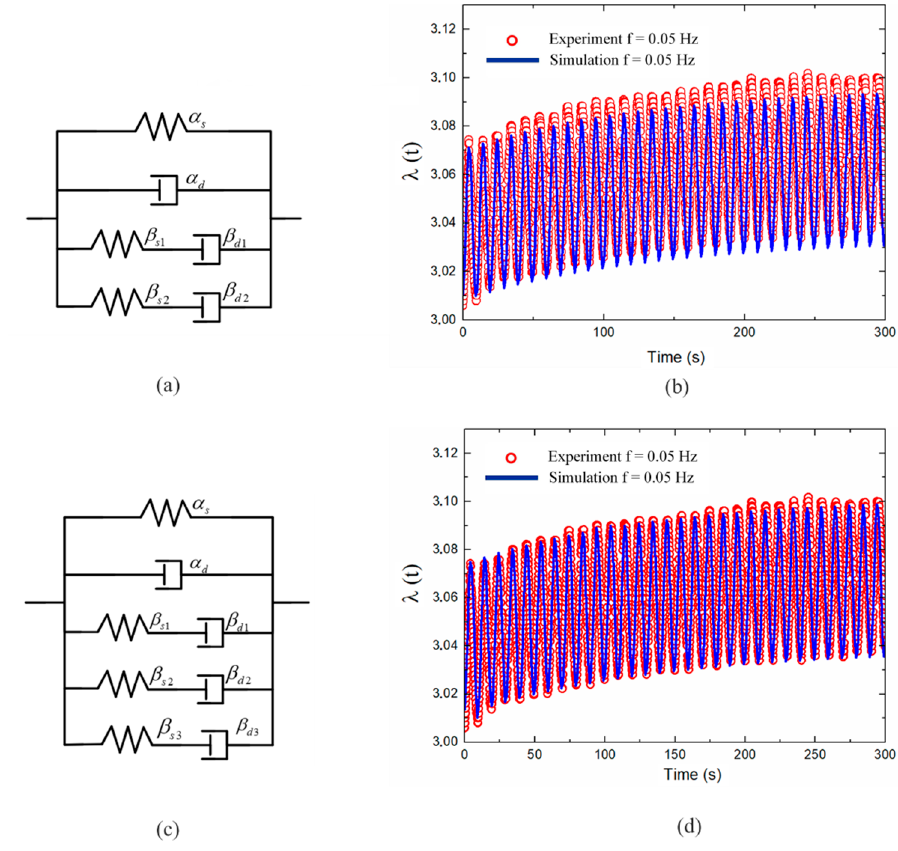
fitting results.